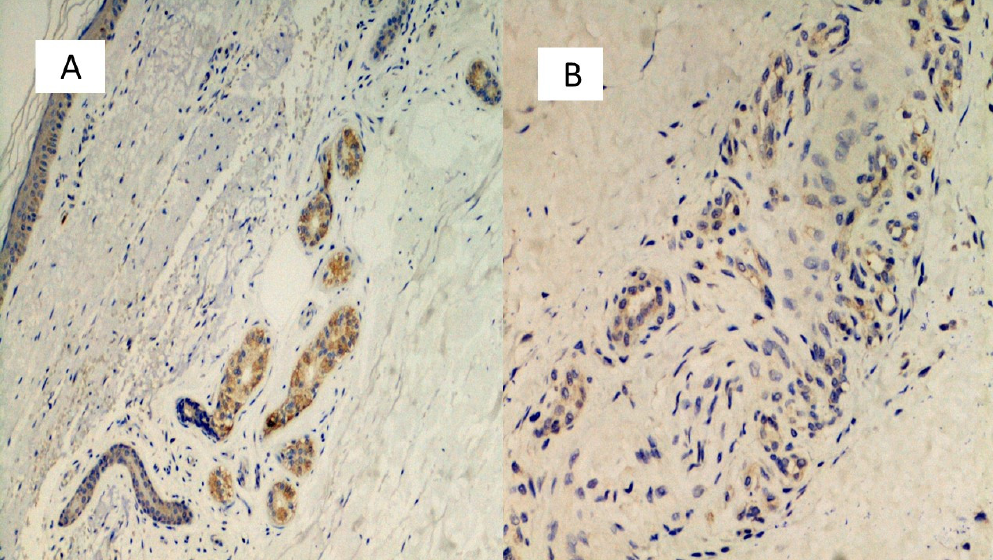
Figure 7. ( A , B ) Preparations for immunostaining with anti-SARS-CoV-2 antibody, showing positivity in the eccrine sweat glands cells, but also in the vascular endothelium ( B ).